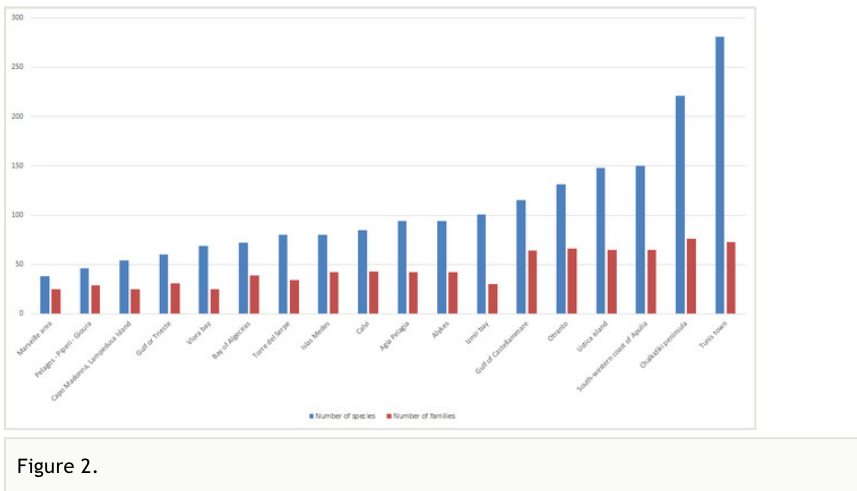
Number of species and families per sampling location. Diagram based on the data from Suppl. material